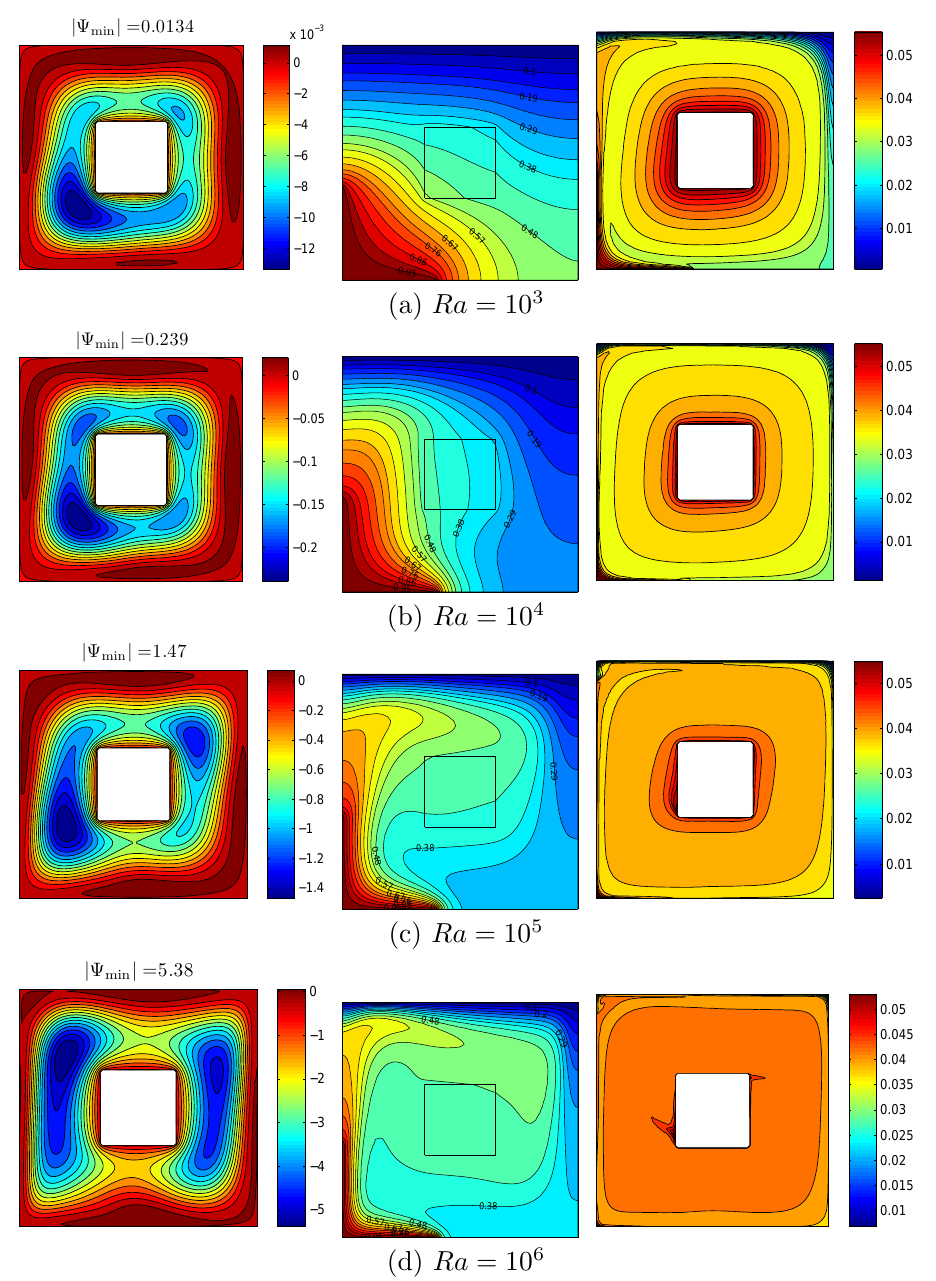
Figure 7. Variations of the streamlines ( left ), isotherms ( middle ), and nanoparticle distribution ( right ) evolution by Rayleigh number ( Ra ) for φ = 0.02, k w = 0.76 and D = 0.3. ( a ) Ra = 10 3 ; ( b ) Ra = 10 4 ; ( c ) Ra = 10 5 ; ( d ) Ra = 10 6